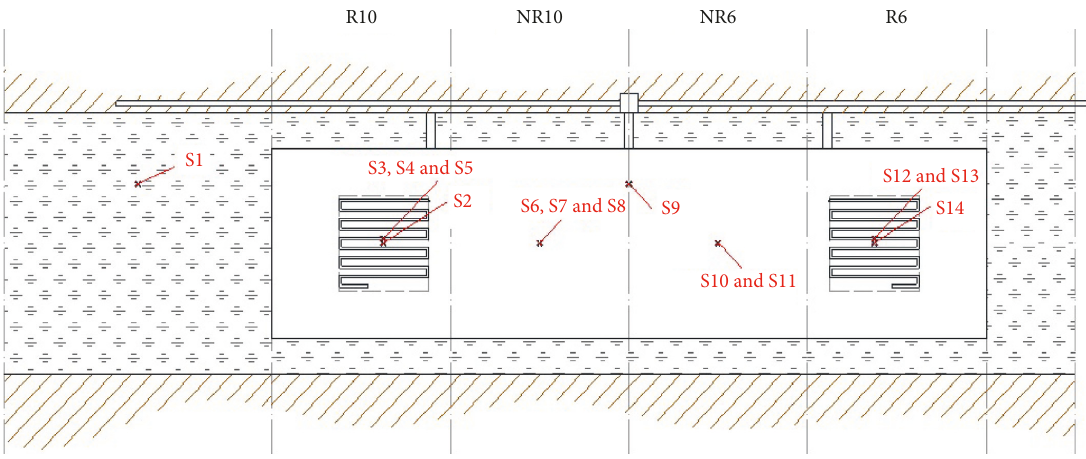
Figure 3: Position of thermistors in the trial field. Note that S2 and S14 are in-between ribbons.